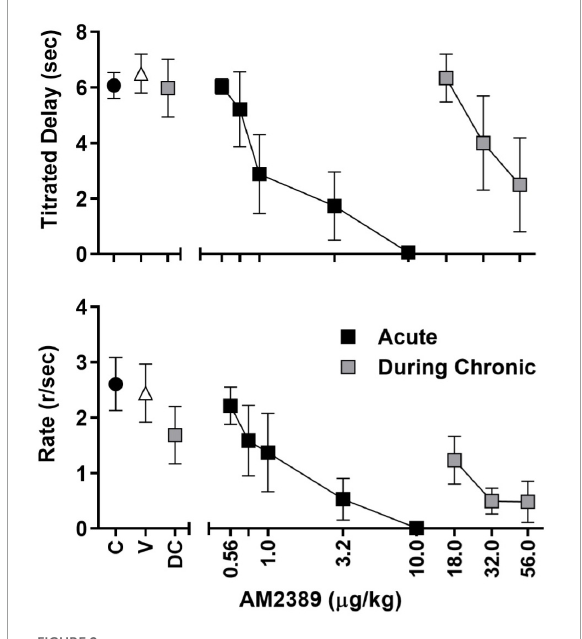
FIGURE2 Session-wide mean ( ± SEM) titrated duration values (upper panel) and mean ( ± SEM) response rate values (lower panel) in the TDMTS task during control sessions prior to drug exposure (C; black circles), following vehicle administration (V), during acute dose-response determinations (black squares), during chronic dose-response determinations (gray squares) N = 4.